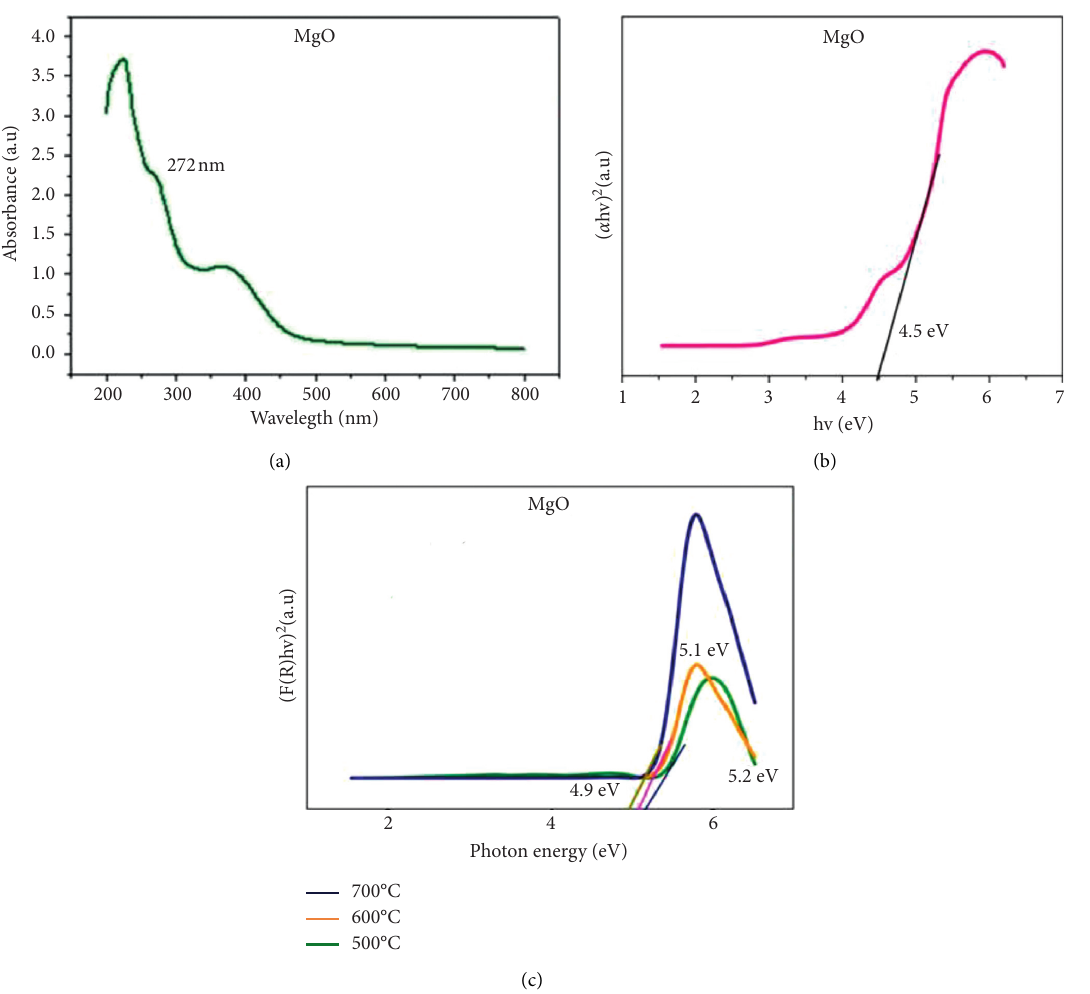
Figure 11: Energy dispersive X-ray spectroscopy (EDX) spectra of MgO nanoparticle (a, b) and atomic percentage of Mg and O